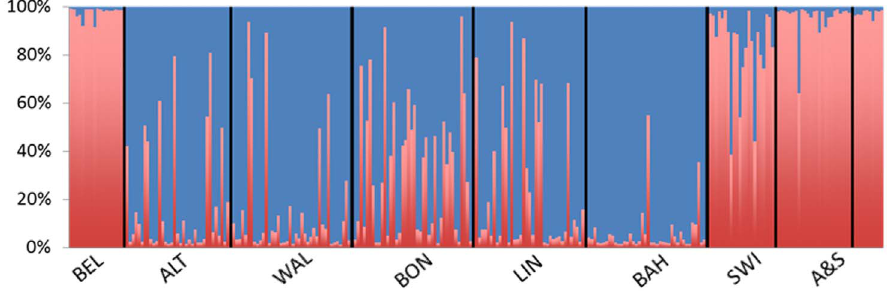
Figure 2. Results of a Bayesian cluster analysis of multilocus microsatellite genotypes. Each individual included in the analysis is represented by a thin vertical line, partitioned into colored segments that represent the individual’s probability of belonging to one of the two most likely genetic clusters. The origin of each specimen was not used in the analysis. Red=genotype 1, green=genotype 2, BEL=Belgium; ALT=Altenrath; WAL=Walberberg; BON=Bonn-Hoholz; LIN=Linz; BAH=Bad Ho¨nningen; SWI=Switzerland; A&S=Austria/Slovenia. One specimen from Bad Ho¨nningen has a genotype indicating it is likely the result of a cross between genotype 1 and genotype 2 (an F1).